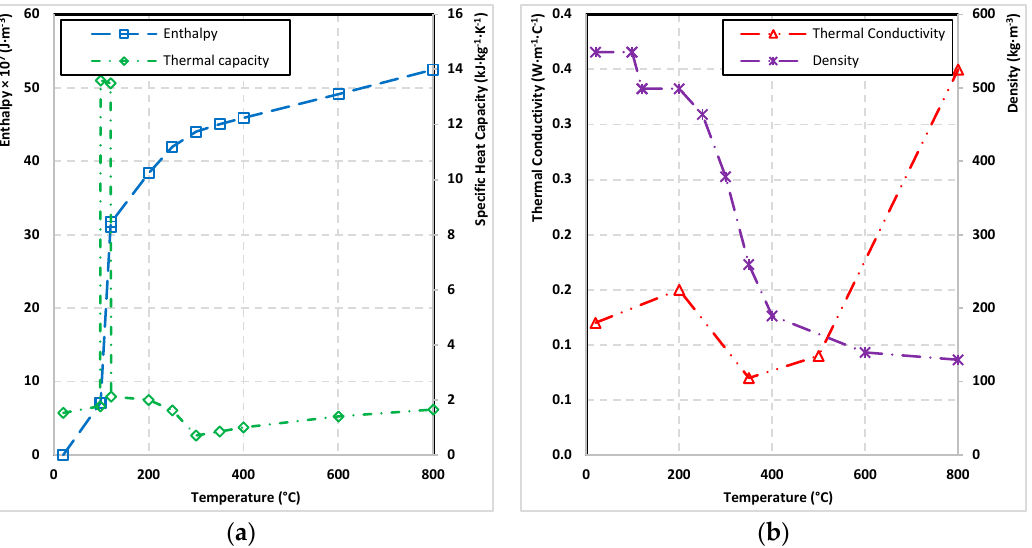
Figure 5. The properties of European larch: ( a ) enthalpy and specific heat capacity, and ( b ) thermal conductivity and density.